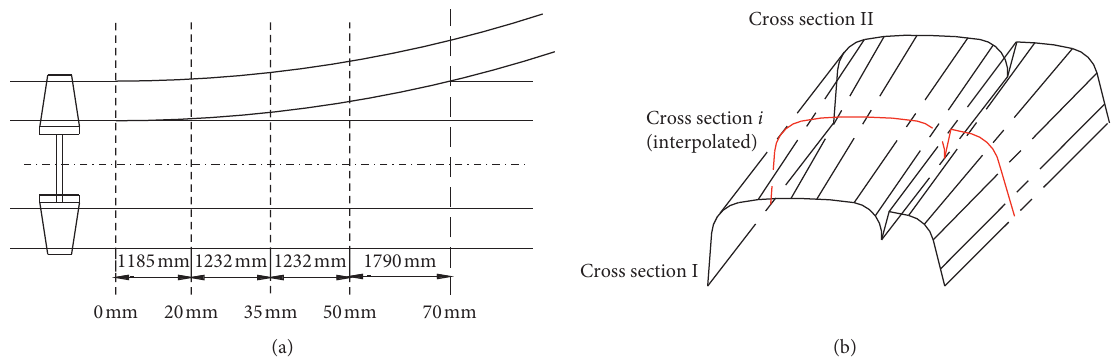
Figure 18: Rail profile in the switch: (a) control cross sections of the rail along the switch; (b) interpolation of the rail